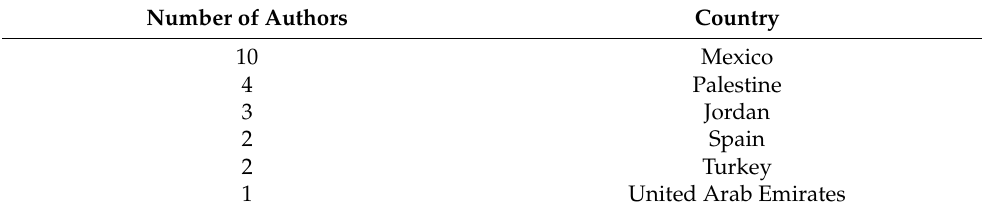
Table 1. Authors’ countries.